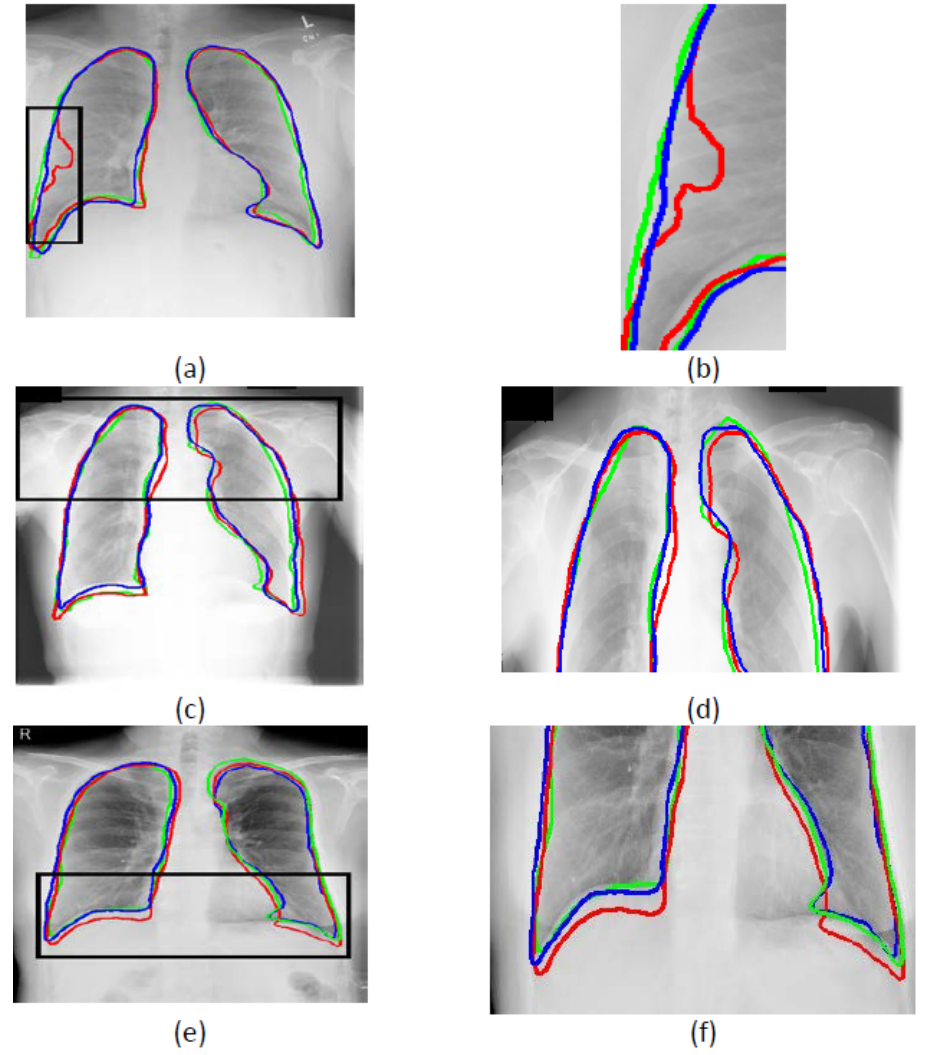
Figure 11. Examples of the boundary adherence between USEQ superpixel interpolation and bicubic interpolation. The blue contours are the results of USEQ, the red contours are the results of bicubic, and the green contours are the ground truth; ( a , c , e ) are the results of LIDC, JSRT, and ANH; ( b , d , f ) are the zoomed-in parts of the black rectangle in ( a , c , e ).